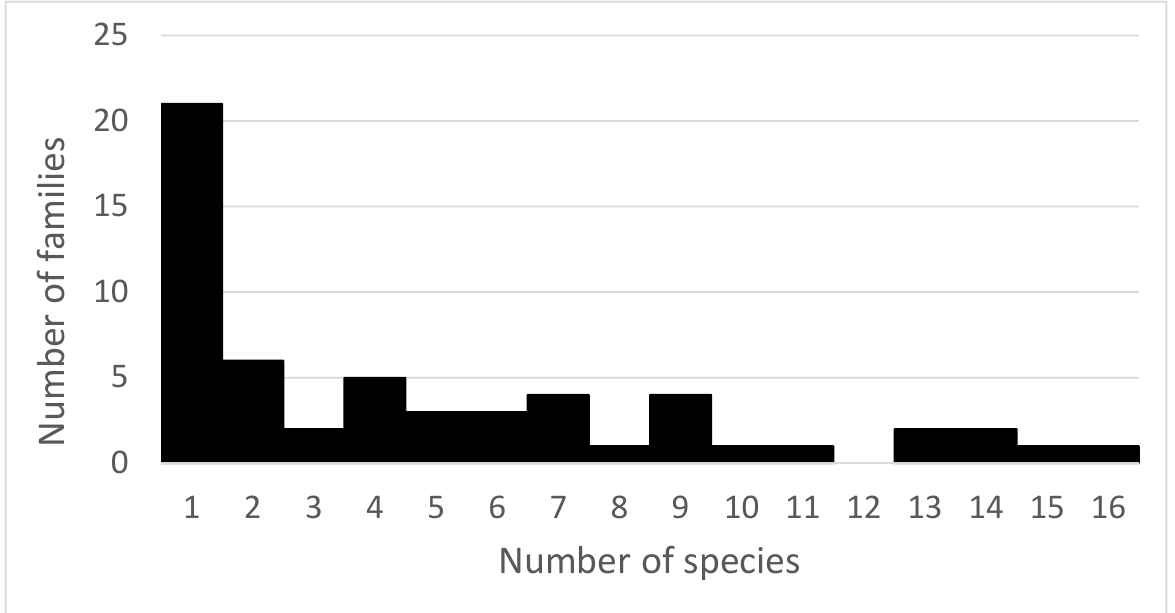
Figure 2. Distribution of the numbers of species belonging to the 57 amphipod families recorded in the English Channel.